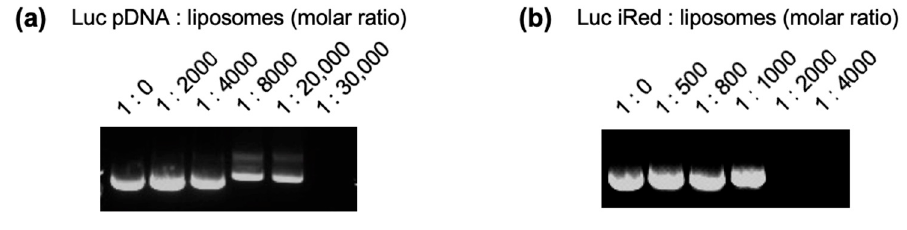
Figure 1. Electrophoretic profile of DNA/liposome-complexes. ( a ) Electrophoretic profile of Luc pDNA/liposome-complexes at different ratios ranging from 1:2000 to 1:30,000. ( b ) Electrophoretic profile of Luc iRed/liposome-complexes at different ratios ranging from 1:500 to 1:4000. The absence of DNA bands indicates that almost 100% of the DNA was associated with cationic liposomes. The lipid composition of cationic liposomes was DOPE, cholesterol and DOTAP (3:3:4 as molar ratio). Table 1. Physicochemical characteristics of DNAs/liposome-complexes and cationic liposomes. Particle sizes and zeta-potentials were measured using the complexes or liposomes at a concentration of 10 mM lipids. Complexes Particle Size (nm) Zeta Potential Particle Size Complexes (nm)